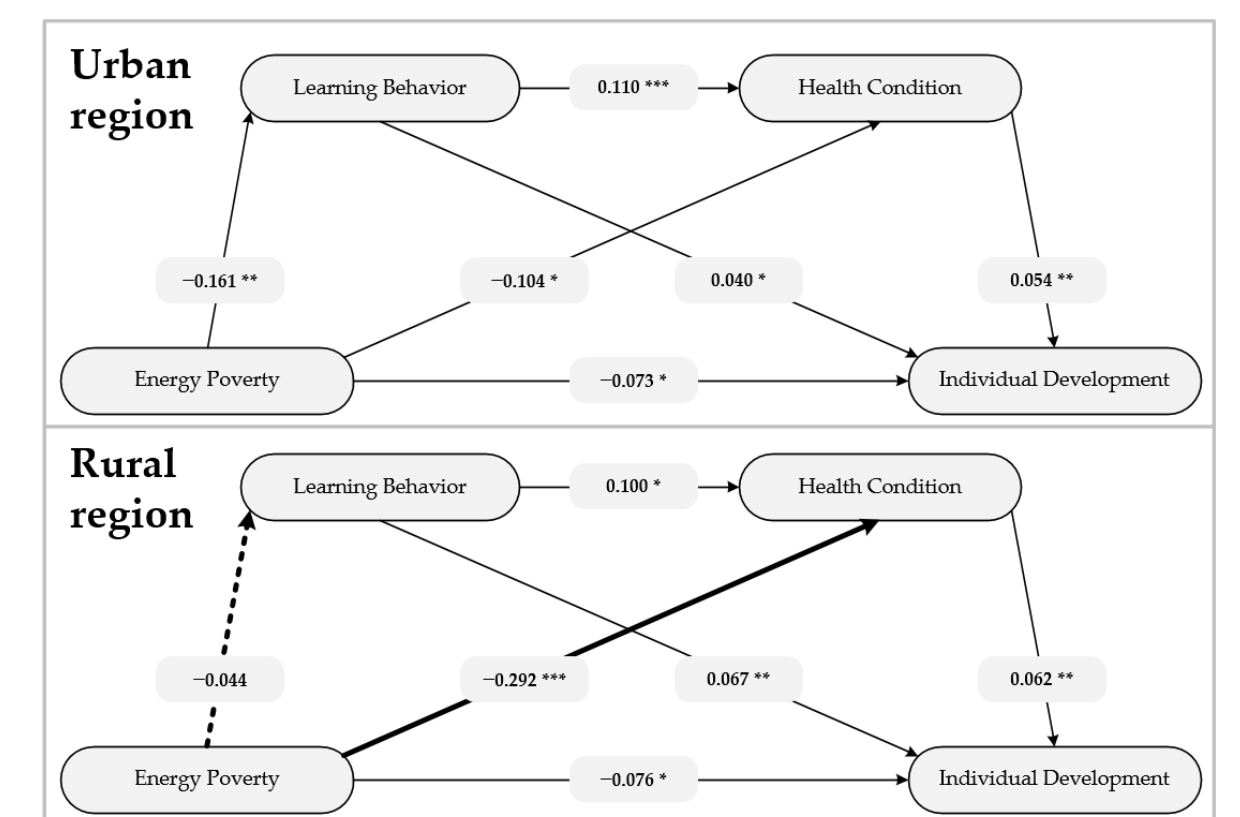
Figure 3. Pathways and coefficient in urban and rural regions. Note. * p < 0.05, ** p < 0.01, *** p < 0.001.